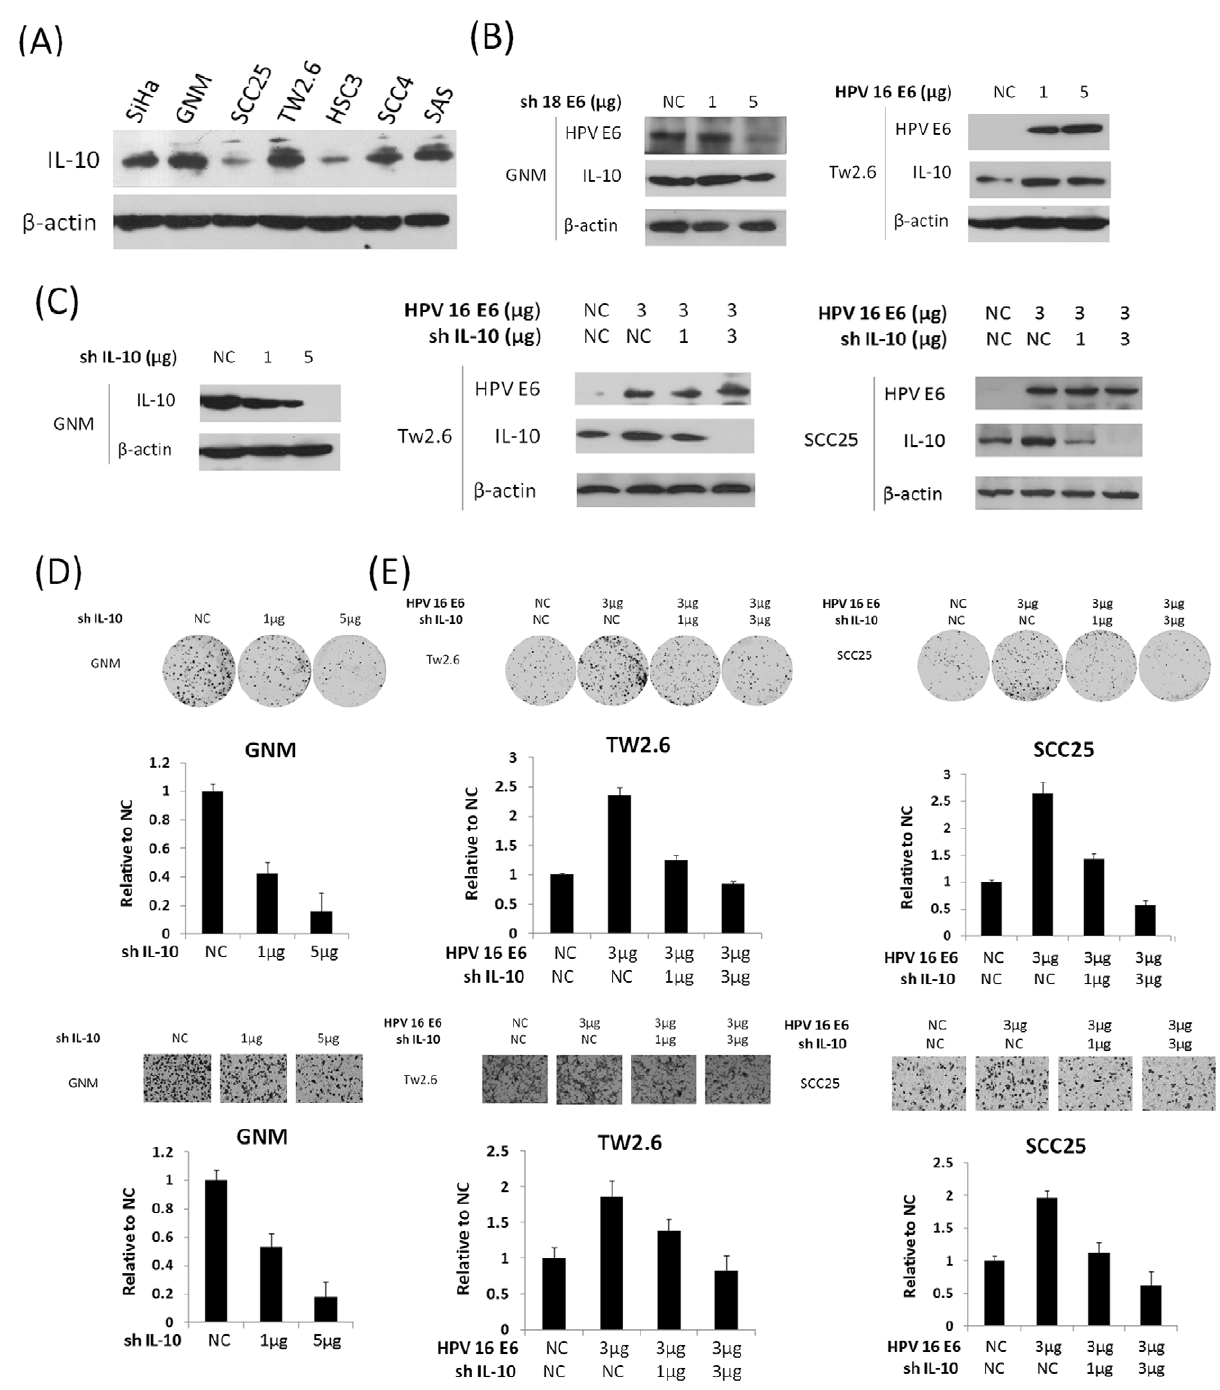
Figure 2. IL-10 expression increases associated with HPV16/18 E6 is responsible for the migration capability of OSCC cell lines. (A) IL-10 expression in a panel of OSCC cell lines was evaluated by Western blotting; (B) GNM cells were knocked down by transfection of shHPV18 E6 and Tw2.6 cells were transiently transfected with HPV16 E6 cDNA plasmid for 48 hrs. b -actin was used as a protein loading control; (C) GNM cells were knocked down by transfection of shIL-10. Tw2.6 and SCC25 cells were co-transfected with HPV16 E6 cDNA plasmid, and then E6 and IL-10 expression were determined by Western blotting. b -actin was used as a protein loading control; (D) The migration and colony formation capability of GNM cells with or without transfection of shIL-10 was evaluated by transwell migration assay; and (E) E6 transfected-Tw2.6 and -SCC25 cells were co-transfected with two doses of shIL-10, and then the migration and colony formation capability of both cells was evaluated by transwell migration assay.